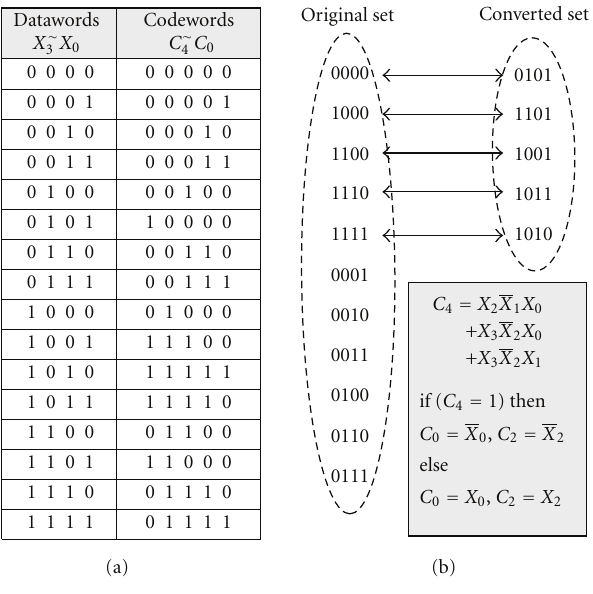
Figure 8: (a) The mapping table between 4-bit dataword and 5- bit codeword of the green bus coding stage. (b) The two sets and Boolean expression of the green bus coding stage.